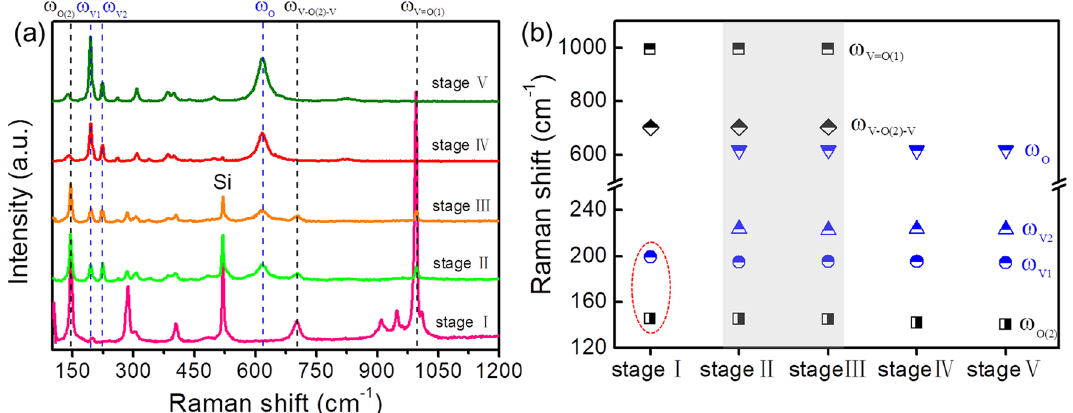
Figure 3. (a) Room-temperature Raman spectra of the growth products at different growth stages. Vertical black and blue dotted lines are the three dominant references Raman peaks of V 2 O 5 and VO 2 (M) structures, respectively. (b) Position evolution of these six Raman peaks during the entire growth